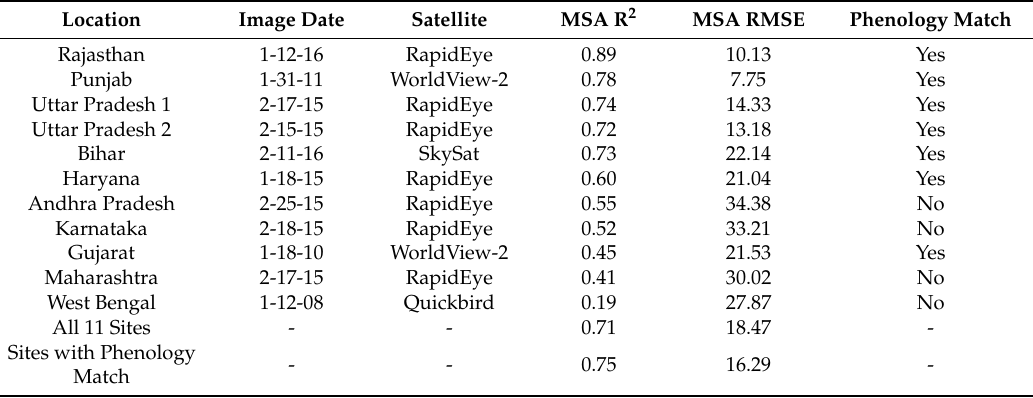
Table 1. Correlation values between our MSA product and estimates of cropped area using classified high-resolution imagery at 1 × 1 km 2 . The date and satellite for each high-resolution image and whether the winter-season window used in our MSA algorithm matched the MODIS EVI phenology of cropped pixels seen in the high-resolution imagery are also